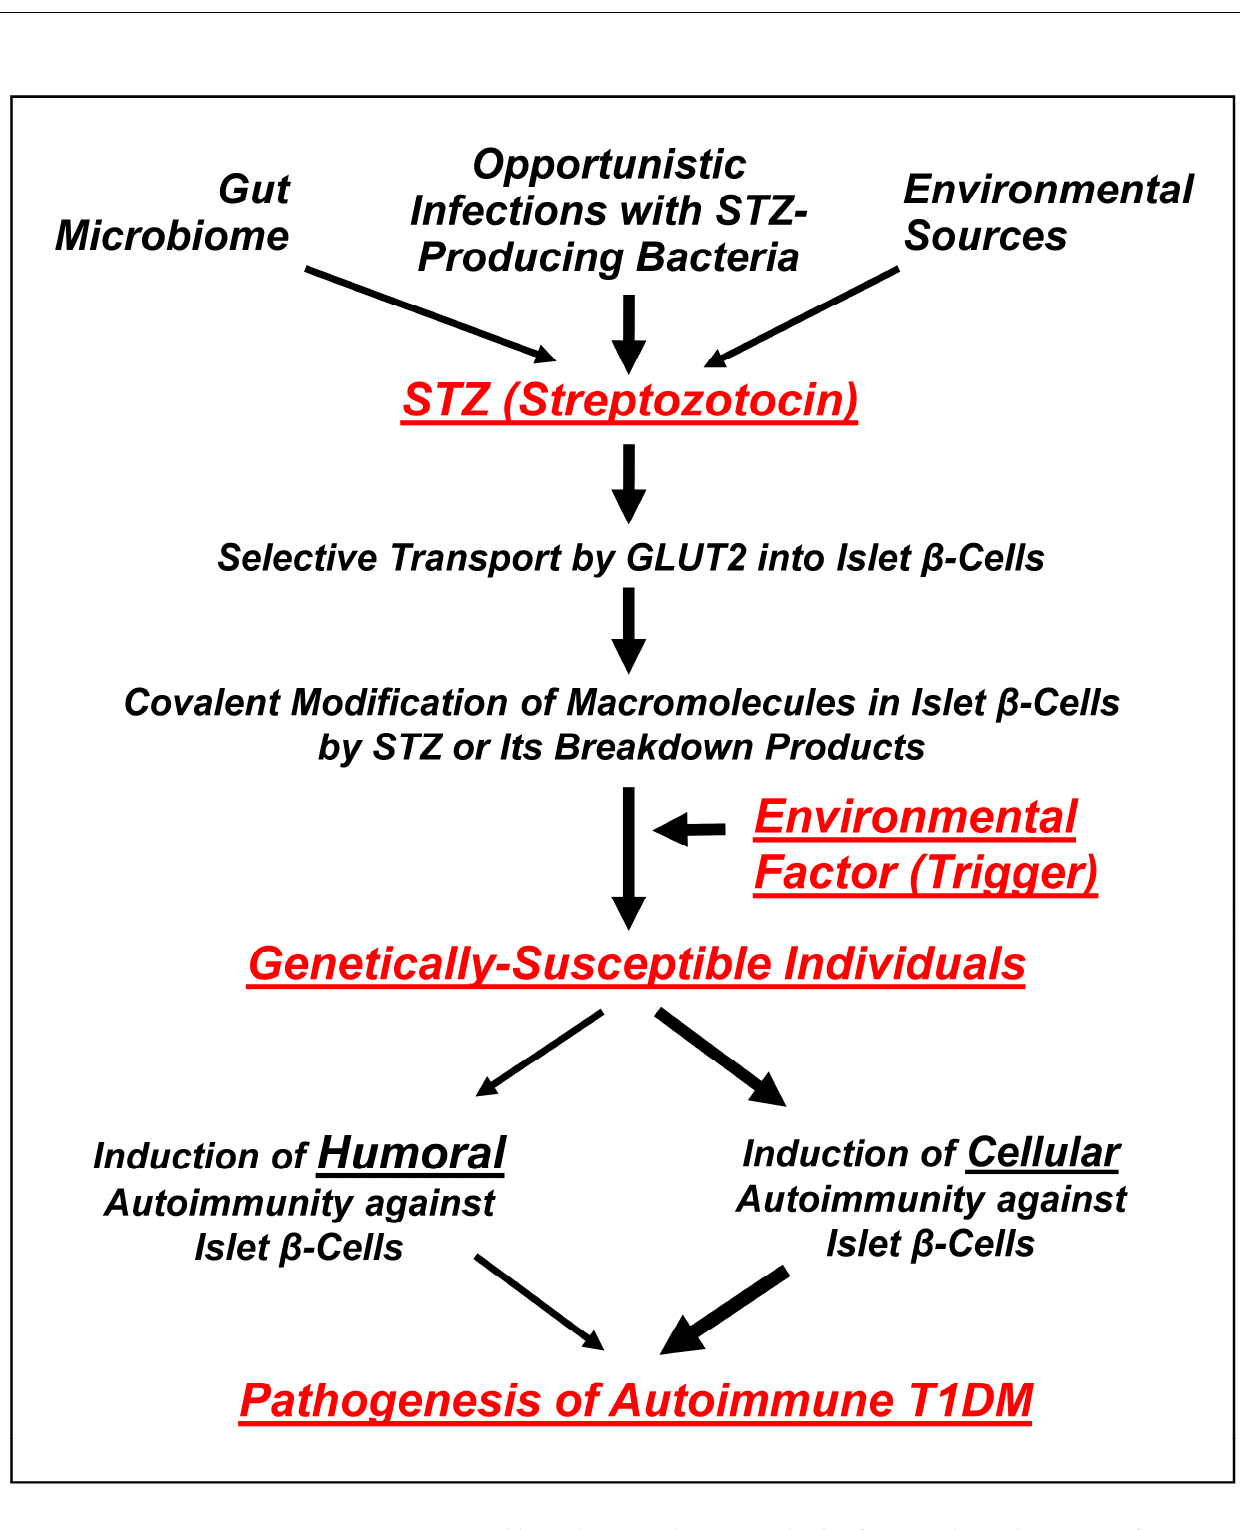
Figure 2. A proposed hypothesis on the potential role of STZ in the pathogenesis of autoimmune T1DM in humans. A detailed description of the hypothesis is provided in the main text under Section 2